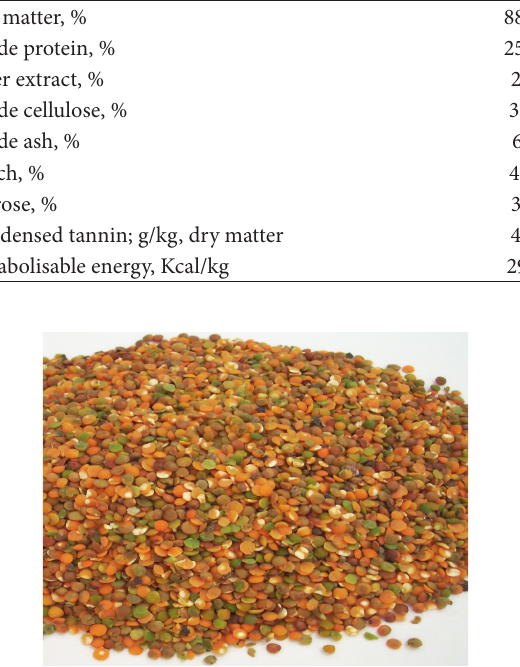
Table 1: Nutrient and tannin contents of lentil byproduct.